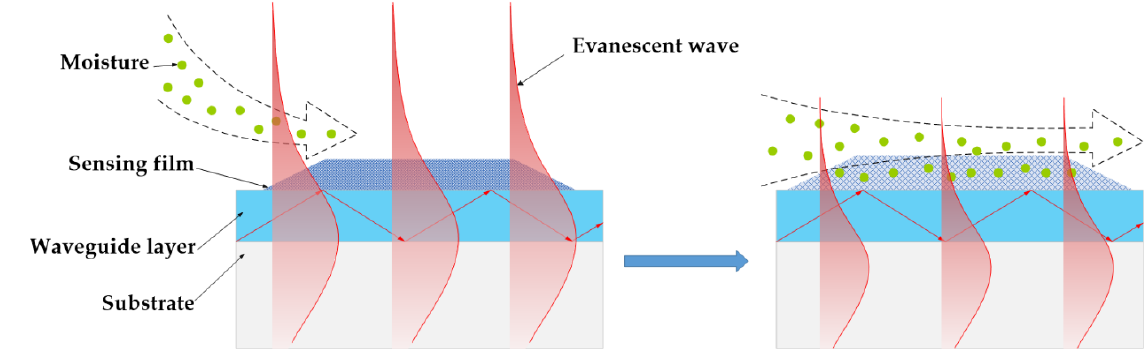
7 of 10 cm and placed in a flask with a specific humidity of water vapor, then its absorption spec- tra were determined). It can be seen that, after the PVP film reacted with water vapor, its absorbance at 633 nm was reduced obviously, which is similar to that of the PVP in etha- nol solution. ( a ) ( b ) Figure 4. Variation of PVP ethanol solution ( a ) and PVP film ( b ) absorption spectra. The relationship between absorbance and RI of the thin film can be explained by the following equation: 𝐴 = lg (cid:3436)1 𝑇(cid:3440) = lg (cid:4680)(cid:4666)𝑛 (cid:2869) + 𝑛 (cid:2870) (cid:4667) (cid:2870) 4𝑛 (cid:2869) 𝑛 (cid:2870) (cid:4681)